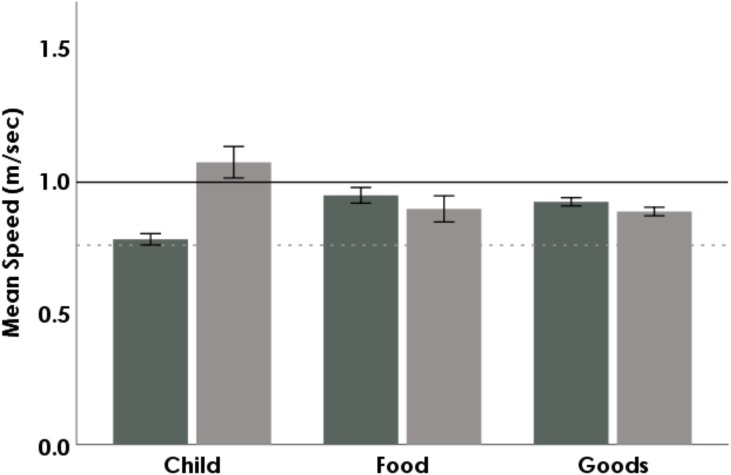
Average speeds of Ugandans (dark grey) and Americans (light grey) carrying either children, food, or goods.Error bars indicate 95% CI. The solid black line represents the unloaded mean for Ugandans; the dotted grey line represents the unloaded mean for Americans.